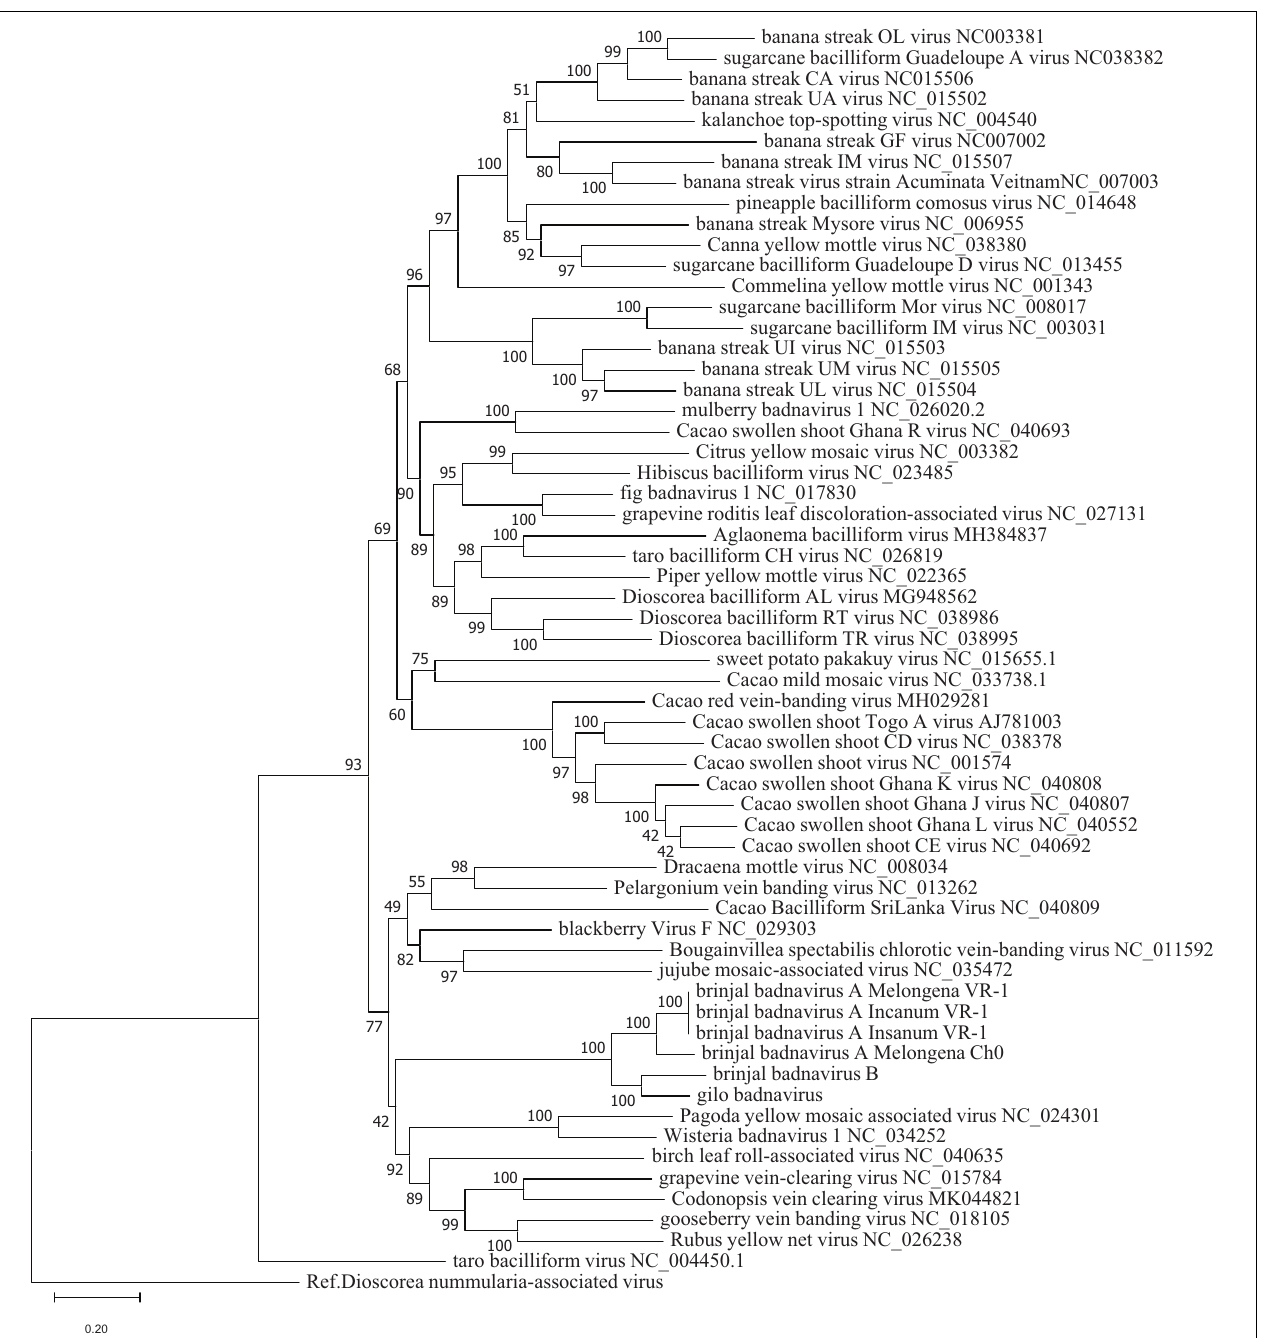
FIGURE 3 | Phylogenetic tree showing placement of BBVA, BBVB, and GBV in genus Badnavirus using ML method. Analysis with 1000 bootstrap sets were performed on nucleotide sequences of the RT-RNase H domains corresponding to positions 5,599–6,882 in the genome of Commelina yellow mosaic virus (NC_001343), the type member of genus Badnavirus . Sequences of the proposed new species are shown in light red box.